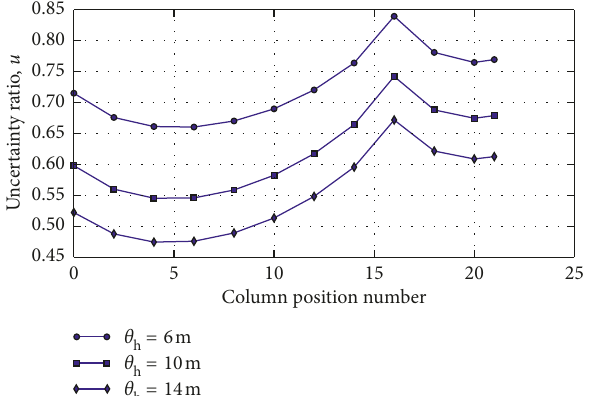
Figure 10: Sampling efficiency indices at different sampling locations for various values of θ example 1.